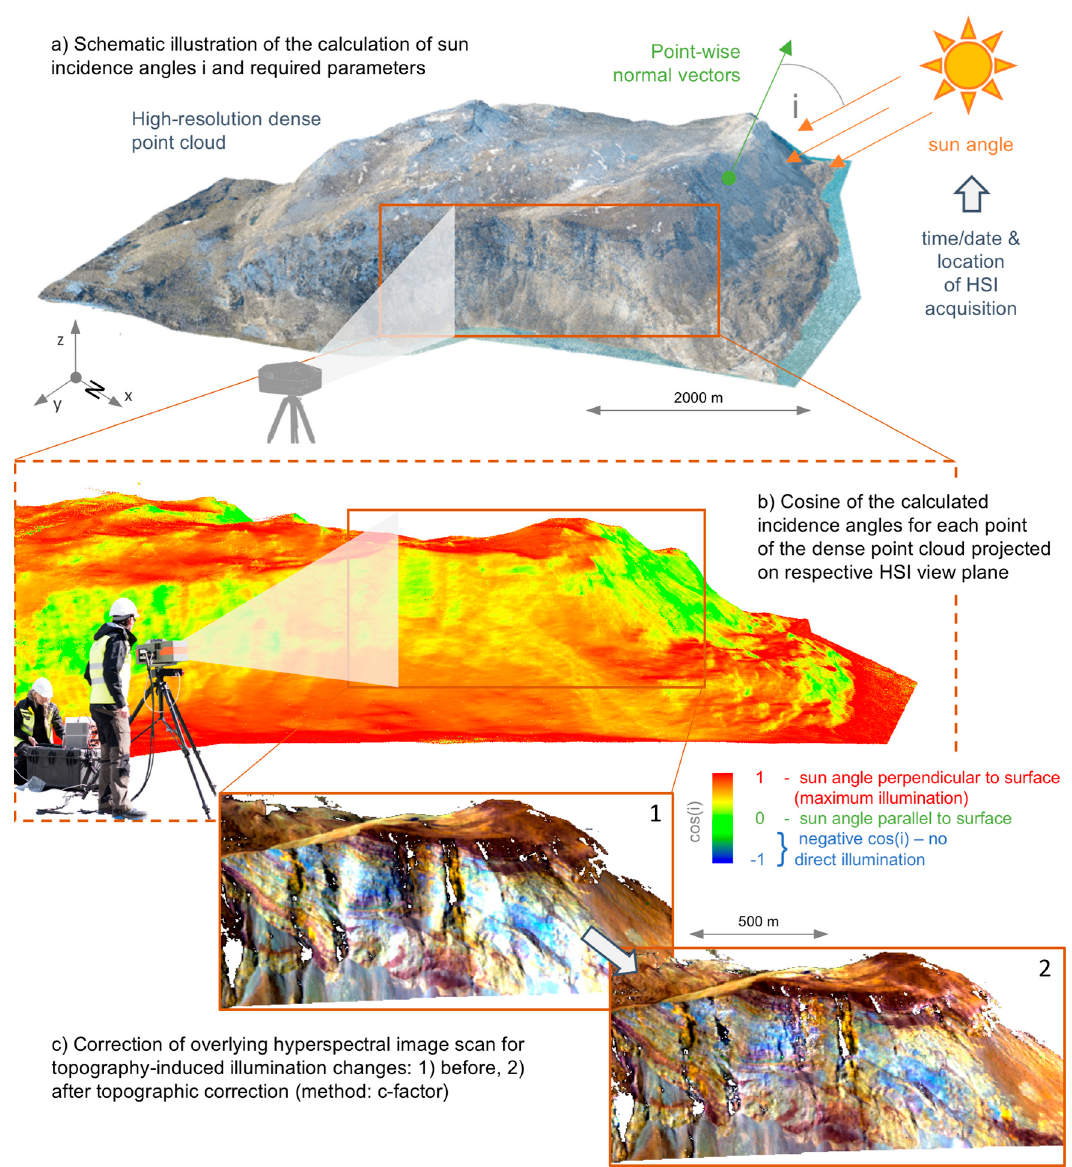
Figure 4. Topographic correction of vertical hyperspectral image (HSI) (Nunngarut, Scan 1). ( a ) Schematic illustration of the calculation of sun incidence angles i and required parameters; ( b ) cosine of the calculated incidence angles for each point of the dense point cloud projected on respective HSI view plane; ( c ) correction of overlying hyperspectral image scan for topography-induced illumination changes: (1) before, (2) after topographic correction (method: c-factor).